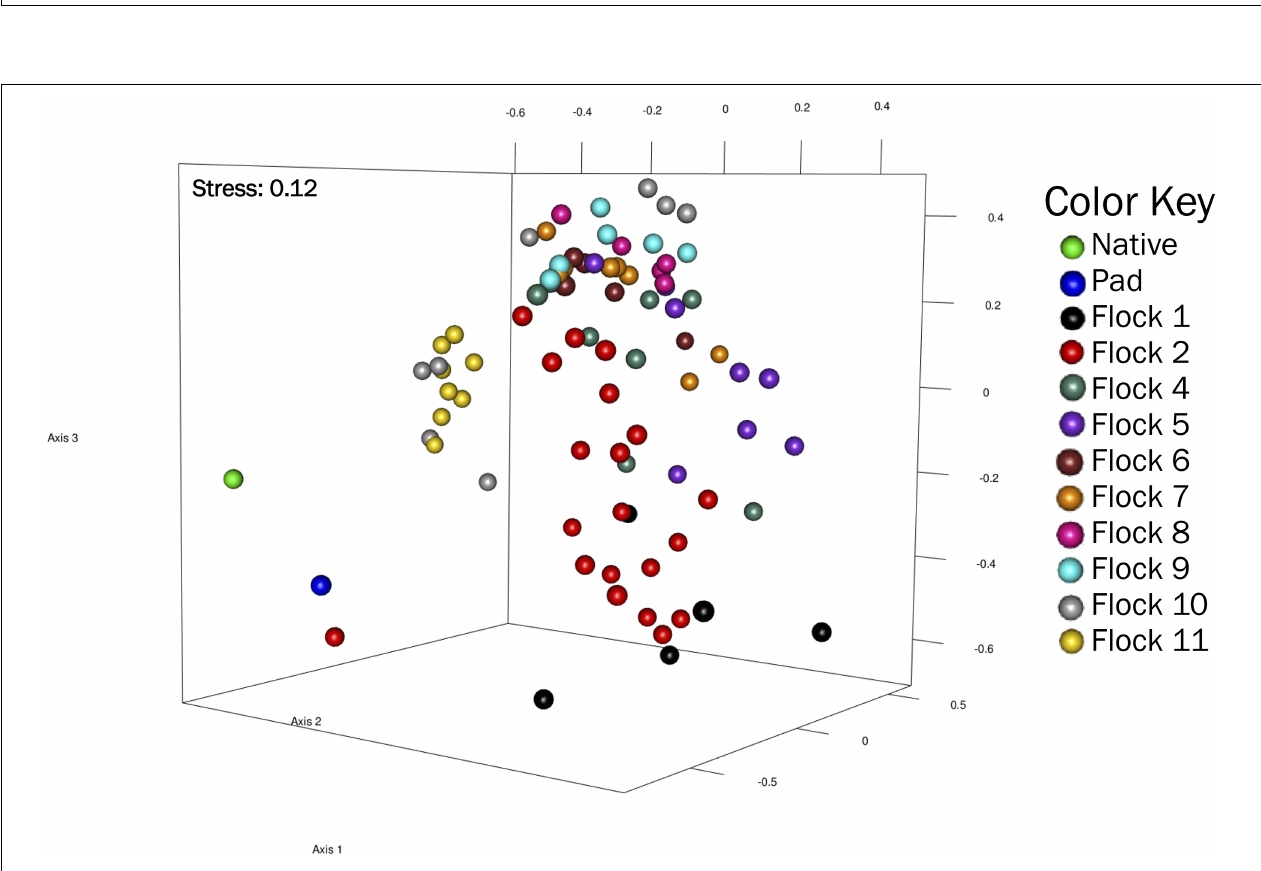
FIGURE 3 | A non-metric multidimensional scaling (NMDS) plot of OTU (at 0.03 genetic distance) based on Yue and Clayton measure of dissimilarity showing clustering of Native, Pad, and Flock samples.